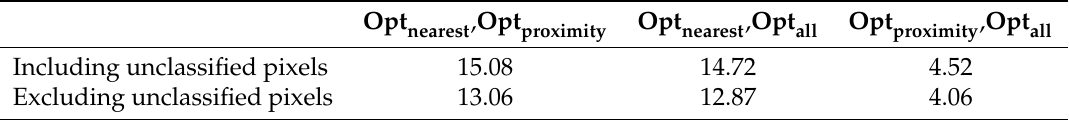
Table 7. Percentage of pixels classified differently when different options are used for representing the